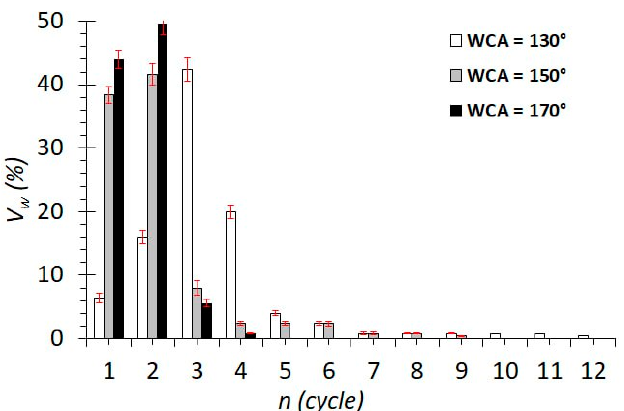
Figure 4. Dependence of the volume of released water on the cycle number for different wetting contact angles.